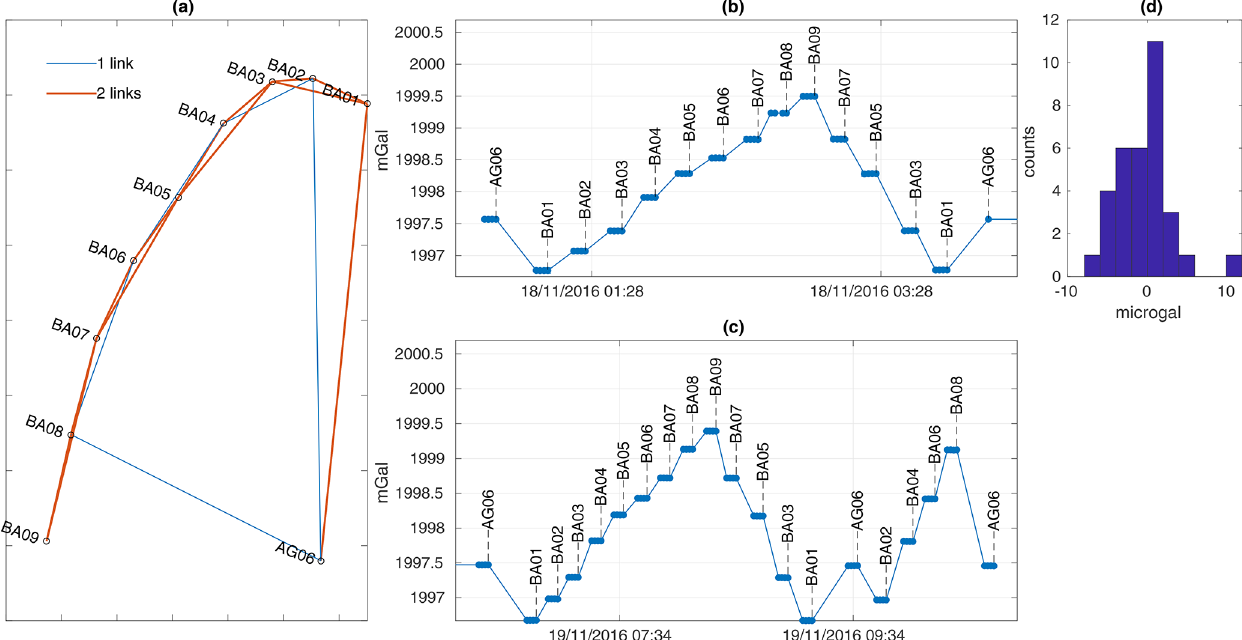
Figure A2. (a) Map view of the relative gravity network with the link between each site for the 2016 survey. (b, c) Gravity readings on the CG-5 at each site as a function of time. (d) Histogram of the residuals after the drift adjustment.